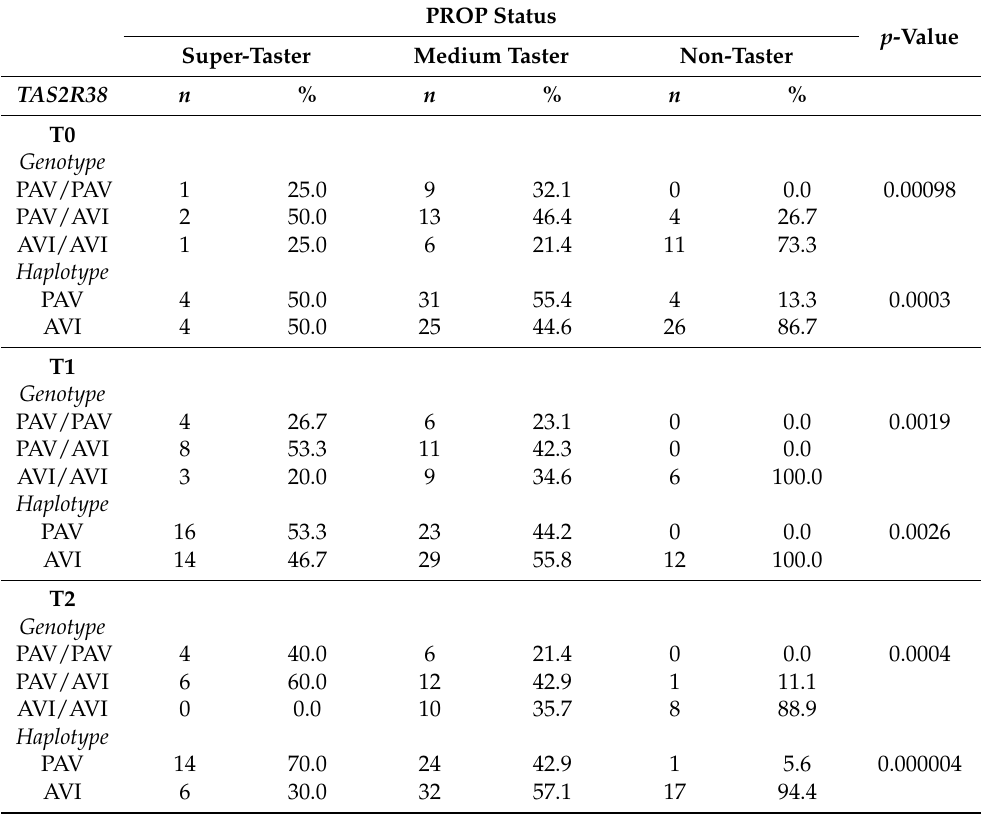
Table 2. Genotype distribution and haplotype frequency of TAS2R38 single nucleotide polymor- phisms (SNPs) according to PROP taster status before (T0), one month (T1) and six months (T2) after bariatric